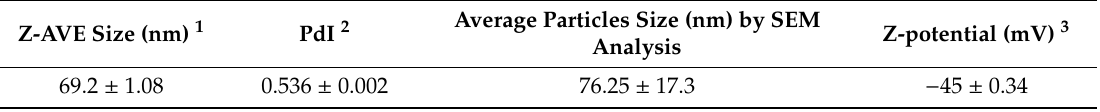
Figure 6. SEM image of CPX 5 particles. Table 3. CPX 5 particle hydrodynamic size, PdI, and Z-potential at 37 °C by dynamic light scattering (DLS) analysis and average particles size by SEM analysis.